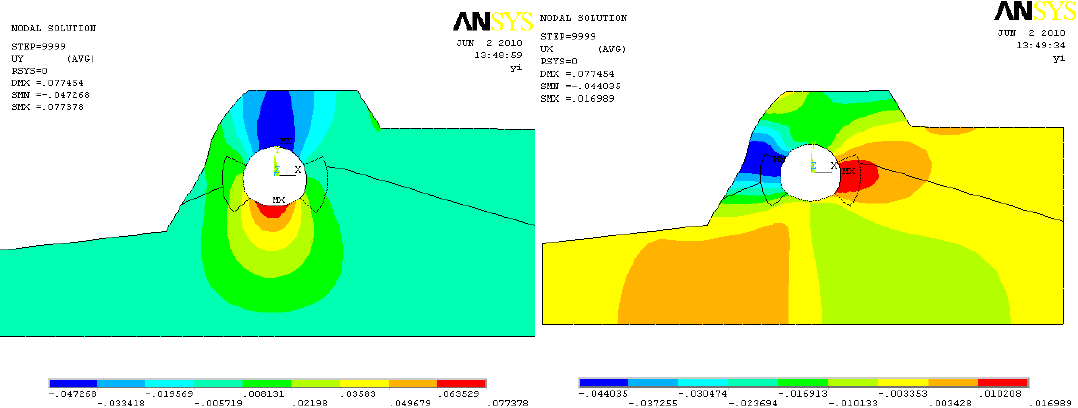
Fig. 3 Construction caused vertical and horizontal displacement.